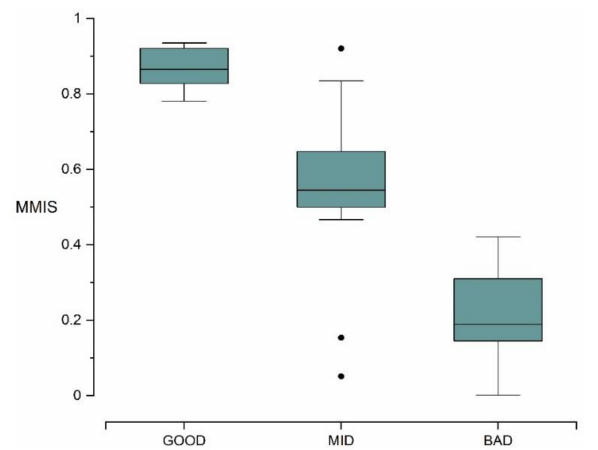
Figure 3. Box plot of multi-metric index (MMI) discrimination ability among different lake types: the abscissa GOOD represents the reference lakes, MID represents the intermediately impaired lakes, and BAD represents the impaired lakes. The ordinate represents the MMIS value.